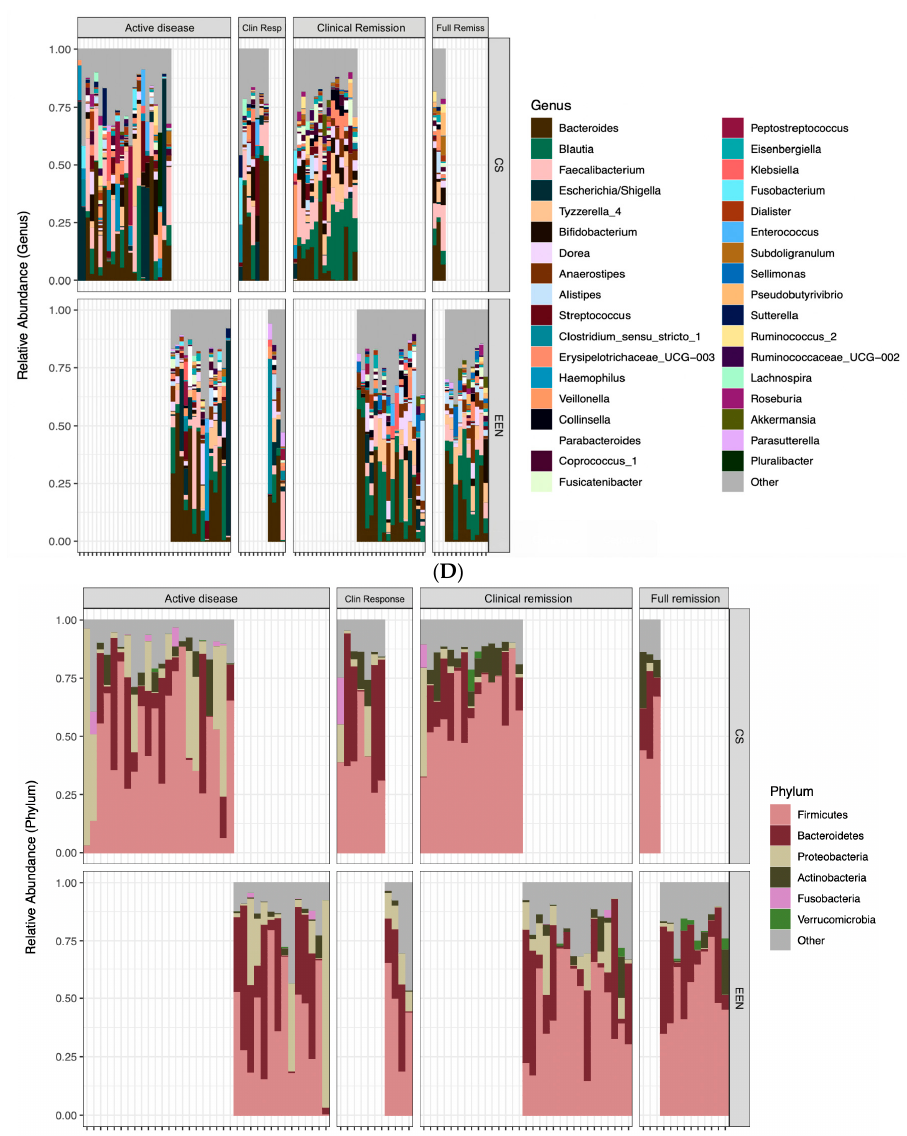
Figure 3. ( A ) Taxa that increased in abundance with disease response. Taxa that increased abundance over the course of treatment (as symptoms improved) were Blautia ( p = 0.045), Sellimonas ( p = 0.002), and uncharacterized bacteria from family Ruminococcaceae ( p = 0.0032). ( B ) Taxa that decreased in abundance with disease response. Taxa that decreased in abundance over the course of treatment (as symptoms improved) were Granulicatella ( p = 0.027), Haemophilus ( p = 0.0001), and Streptococcus ( p = 0.002). ( C ) Taxa with significant changes in abundance but an unclear disease response. There was a significant association of disease state with abundance but no clear linear pattern of change with Bacteroides ( p = 0.03) and uncharacterized bacteria from family Peptostreptococcaceae ( p = 0.00005). ( D ) The relative abundance of bacterial genera in terms of the treatment and disease state. The microbial community structure at the genus level of CD and UC patients receiving either CS or EEN therapy in terms of the phase of treatment. Greater abundances of Bacteroides , Blautia , and Faecalibacterium were noted from an active disease at the clinical response, clinical remission, and full remission stages in both treatment groups. ( E ) The relative abundance of bacterial phylum in terms of the treatment and disease state. The microbial community structure at the phylum level of CD and UC patients receiving either CS or EEN therapy in terms of the phase of treatment. CS—corticosteroids, EEN—exclusive enteral